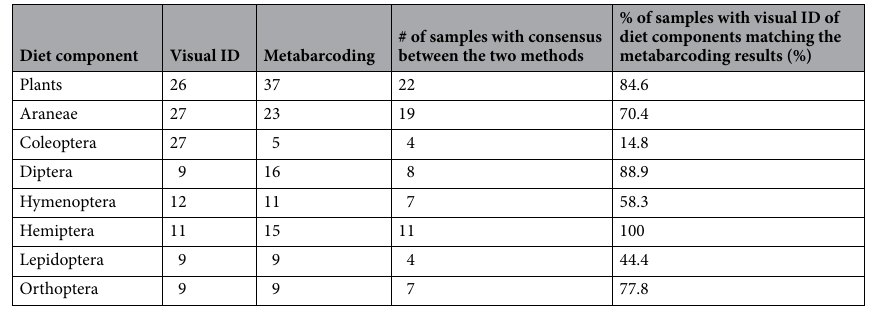
Table 1. Comparison between diet items identified in the regurgitated samples from the two approaches (visual identification and metabarcoding). Identification of plants is limited to the domain level in the visual method. Invertebrate identification is done at order level to enable comparison between the two